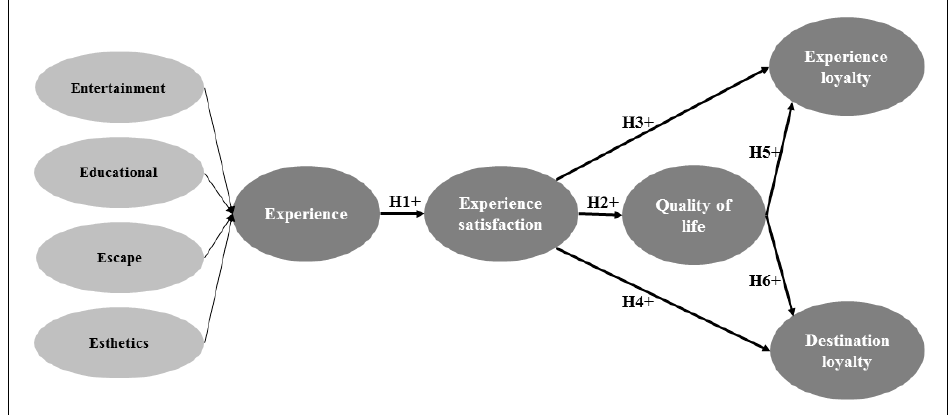
Figure 1. Theoretical model.